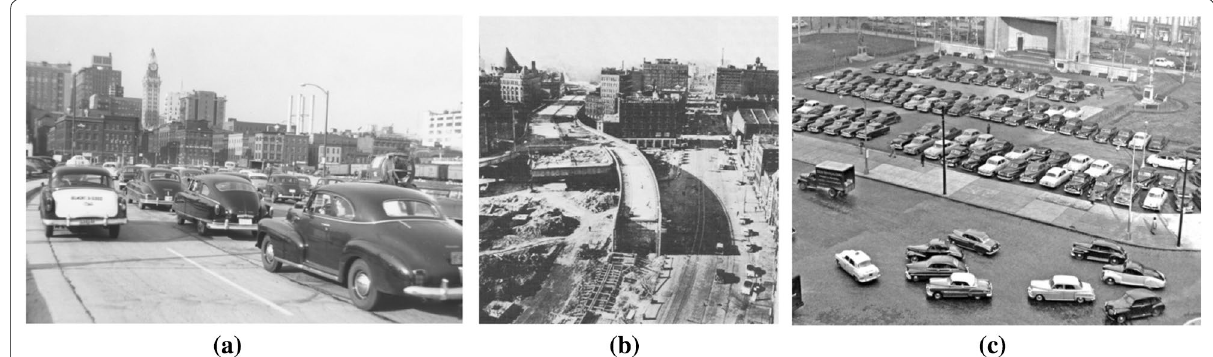
Fig. 3 Cars and highways of the 1950s: urban expansion and decentralization (Pinterest). a Cars dominate the urban space. b Highways cut through downtowns. c Car parking